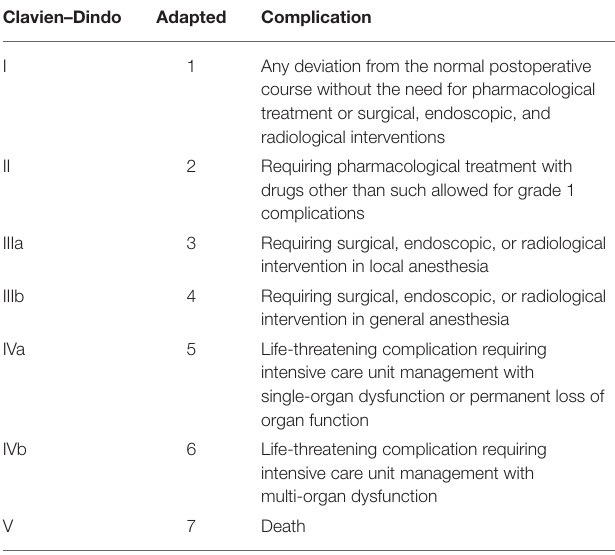
TABLE 1 | The modified Clavien–Dindo classification.